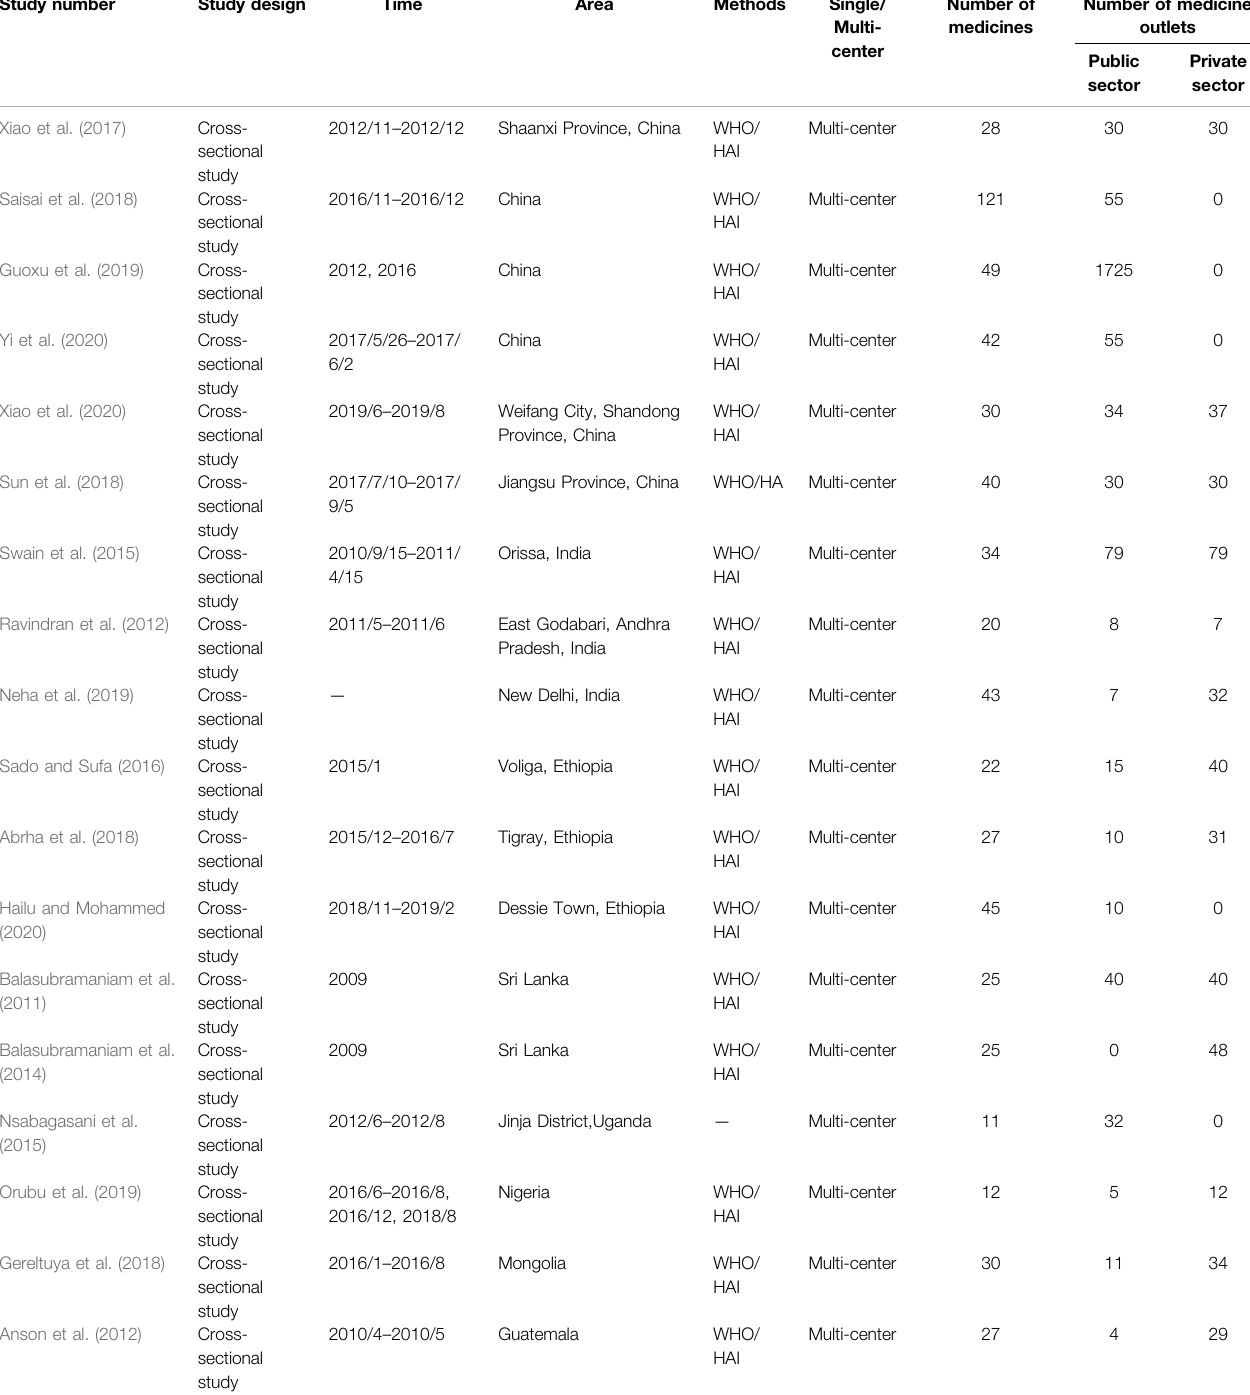
TABLE 1 | Basic characteristics of included